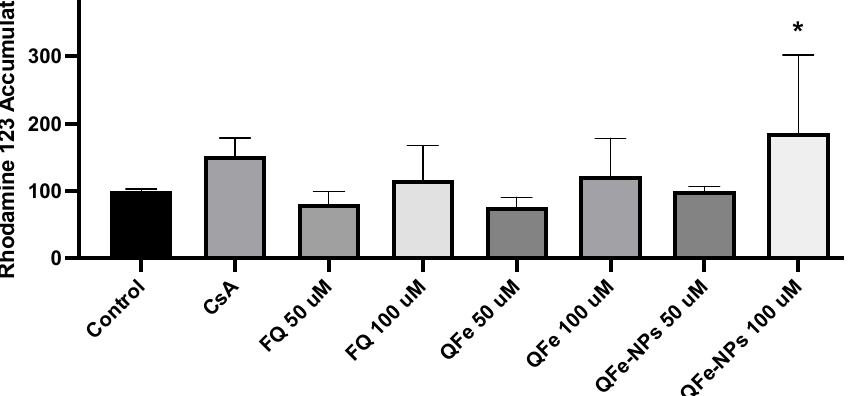
Figure 8. Rhodamine 123 accumulation inside BECs treated with free quercetin (FQ), the QFe complex with a 2:1 Q-Fe ratio, or QFeNPs with a 1:5 Q-Fe ratio at 50 µM and 100 µM along with CsA, as a positive control, and cells without treatment as a negative control. Data are presented as mean values from two independent iPSC-derived BEC differentiations conducted in triplicate ( n = 6). Error bars represent SD. An ANOVA was used to determine significance compared to the control. * p < 0.05.